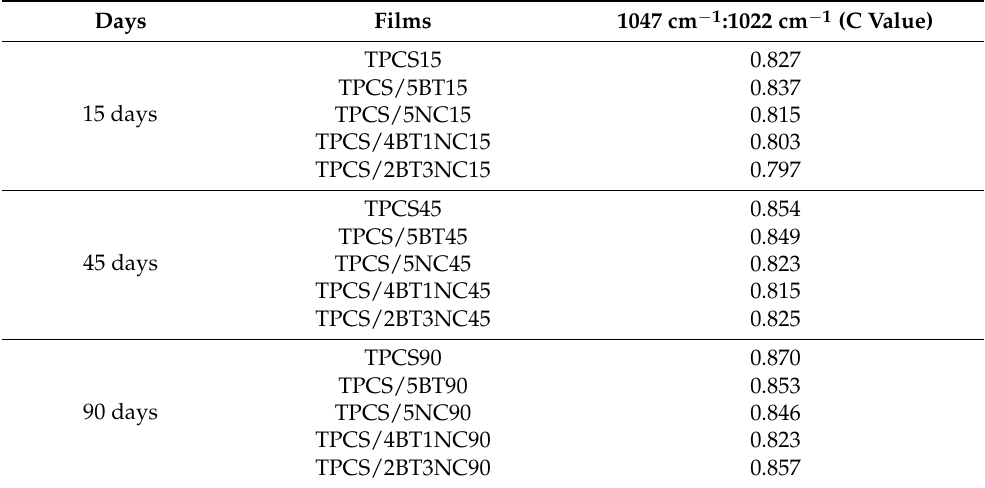
Table 4. The ratio of 1047 cm − 1 :1022 cm − 1 (C value) of TPCS, TPCS-C, and TPCS-HC films after 15, 45, and 90 days of